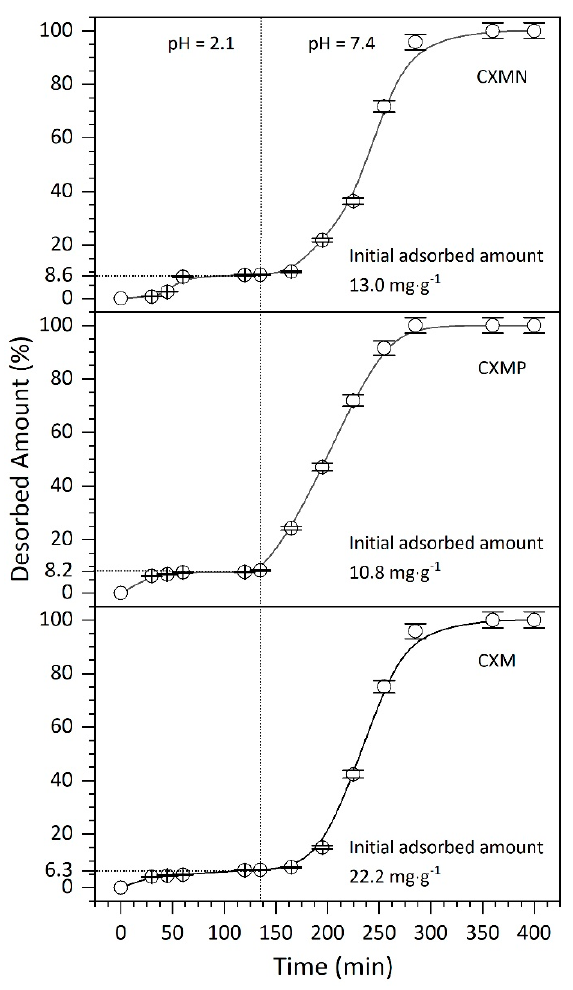
Figure 4. Desorption kinetics of cannabidiol (CBD) from carbon xerogel microspheres (CXMs) and CXMs functionalized with melamine (CXMN) and phosphoric acid (CXMP) at 37 °C and at pH = 2.1 2.1 (gastric medium: bu ff er CH 3 COONa / CH 3 COOH) and pH = 7.4 (final desorption at (gastric medium: buffer CH 3 COONa/CH 3 COOH) and pH = 7.4 (final desorption at intestinal conditions: buffer Na 2 HPO 4 /NaH 2 PO 4 ).